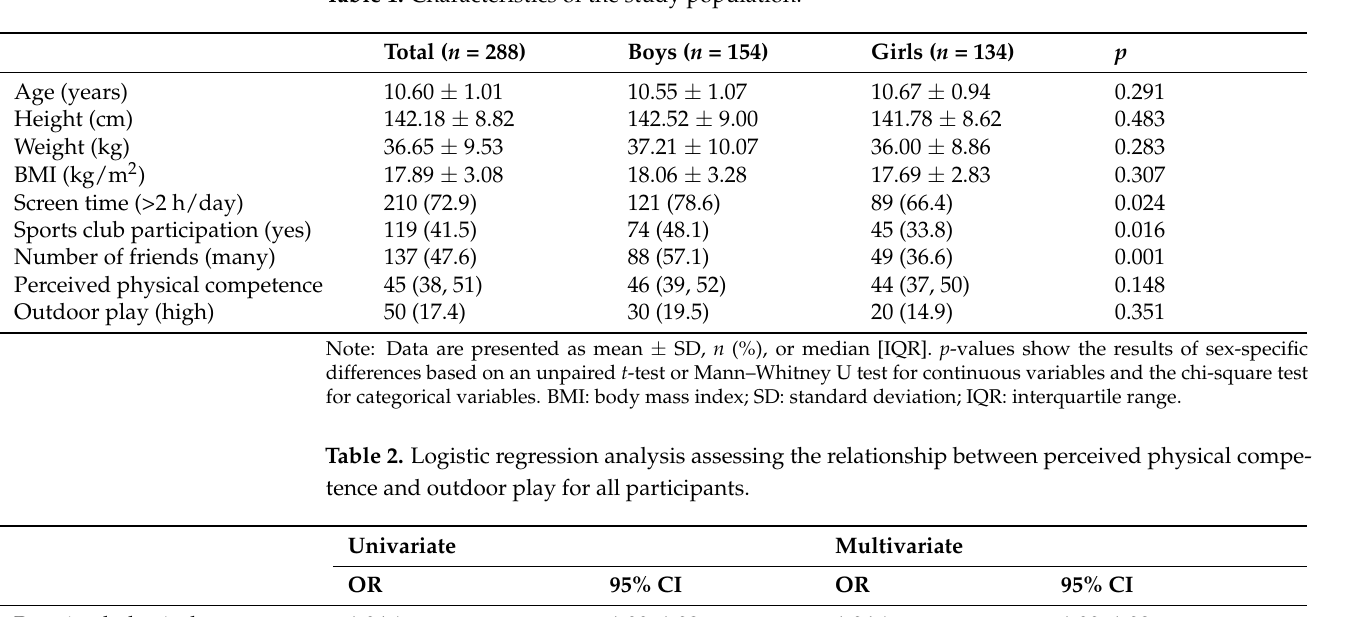
Table 1. Characteristics of the study population.